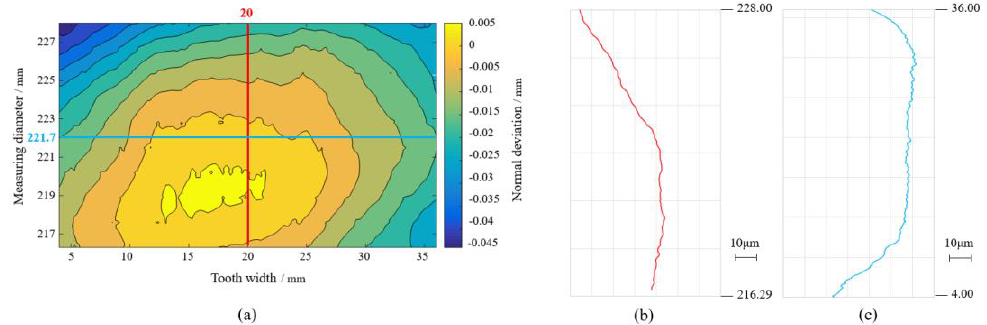
Figure 10. Extraction of the profile and helix deviations: ( a ) 3D topological error, ( b ) profile deviations, and ( c ) helix deviations.